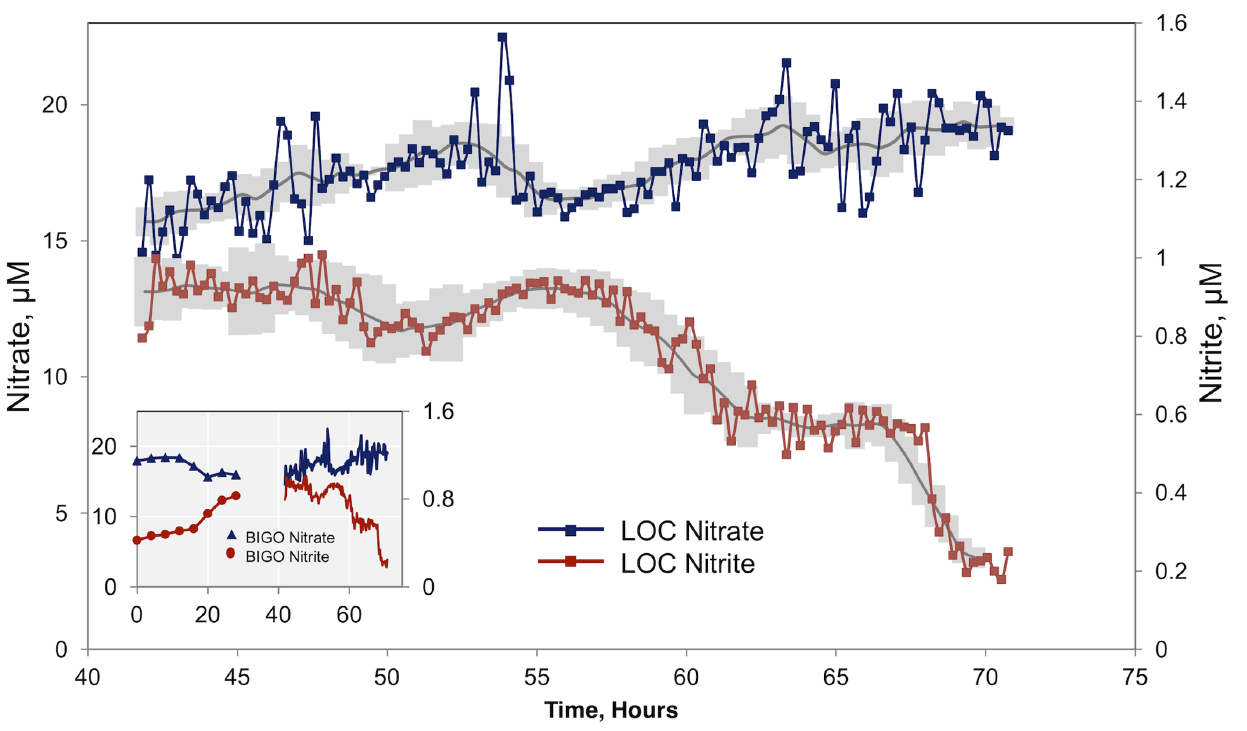
Fig 5. Simultaneous measurements of NO 3- and NO 2- at 50 m depth. Gray lines indicate 12-point moving averages. Also plotted as gray shading are ‘ moving uncertainities ’ calculated from two times the moving (n = 5) standard deviations of the successive in situ measurements of a standard calibration solution. The data from bottom water samples from a previous lander deployment (BIGOII-4) at this depth are also given in the inset. The time zero is set at the beginning of the BIGOII-4 deployment. When the time series from the lab-on-chip sensor are appended to the BIGOII-4 data (inset), a 3-day cycle emerges where the original NO 2- poor, NO 3- rich bottom water is replaced by water of higher NO 2- and lower NO 3- . The water chemistry returns to original situation at the end of the 72-hour